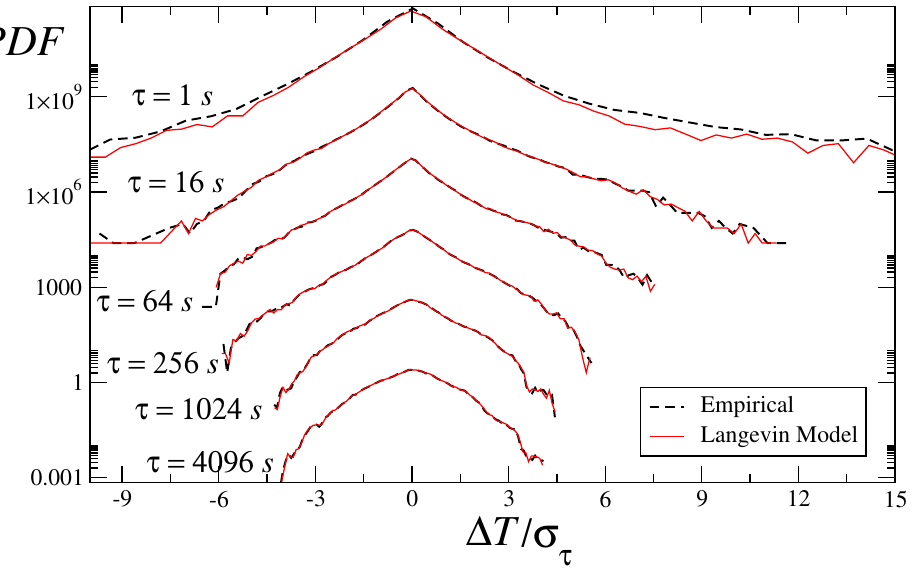
Figure 6. Reconstruction of the probability density function of the increments (fluctuations) of the torque at Turbine AV5. Time is in seconds, and the torque increments are in units of corresponding standard deviations ( σ τ